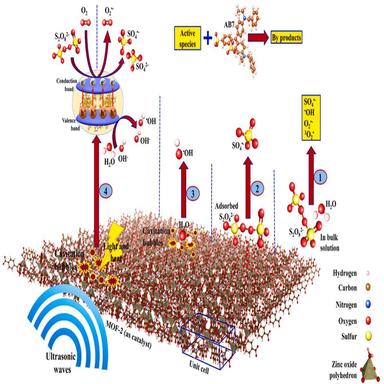
Mechanism of the sonophotocatalytic degradation of AB7 over the surface of the MOF-2 catalyst (, Copyright (2020) Elsevier.